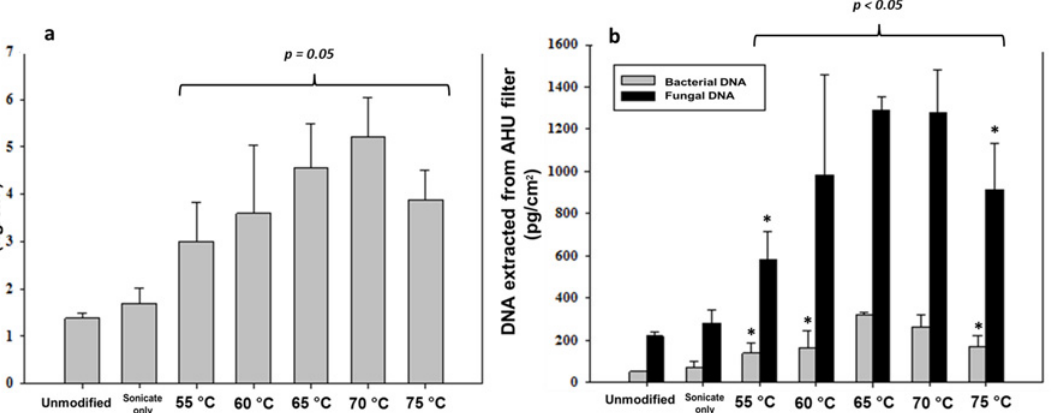
Fig 3. DNA measurements of AHU filter samples for seven treatment pathways of sonication at varying temperature. (a) — Total DNA yields (Qubit). (b) – Results from bacterial and fungal qPCR . N = 4 for each case. * denotes statistically significant difference to mean of DNA yield extracted with 65°C